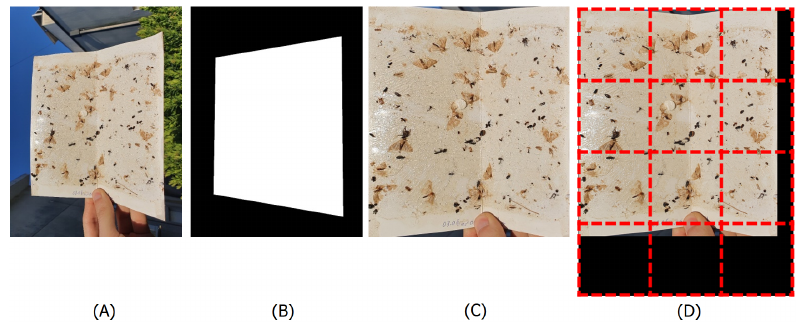
Figure 3. Image patches extraction: ( A ) original image; ( B ) trap segmentation; ( C ) trap perspective correction; ( D ) patches